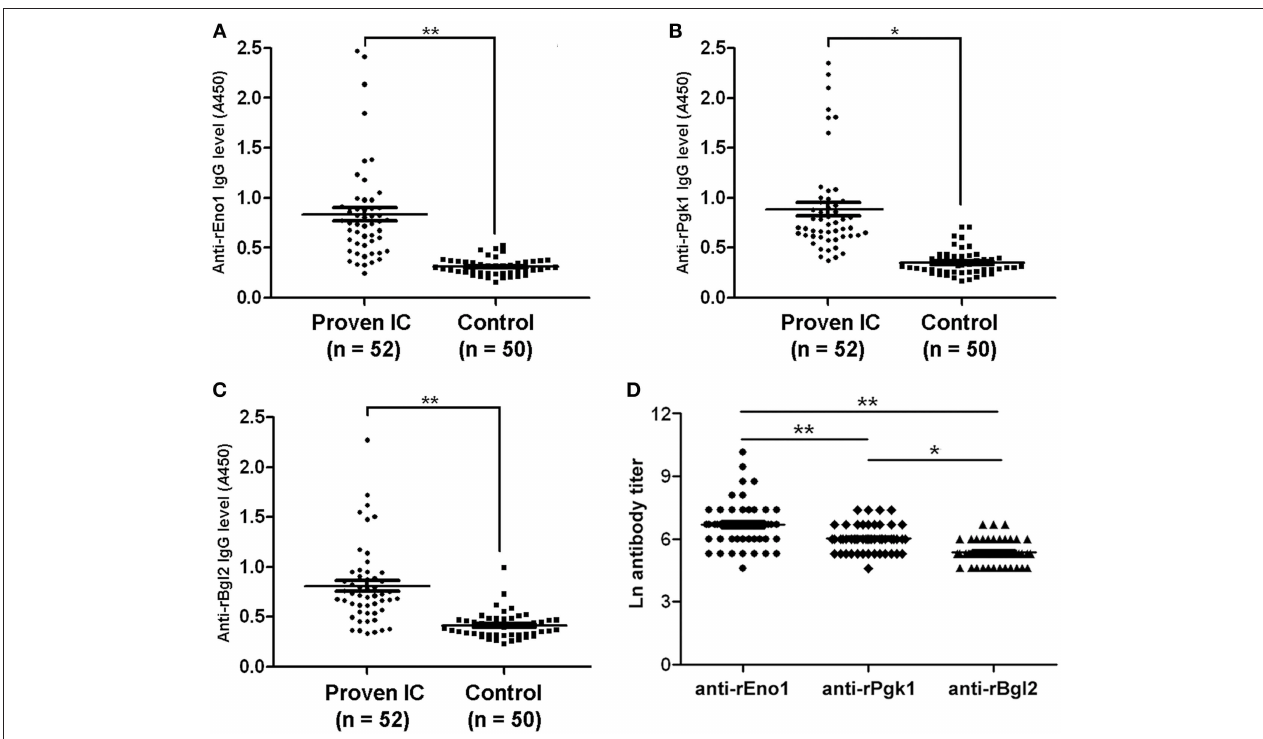
FIGURE 4 | Antibody levels and titers in study patients. The levels of anti-rEno1 (A) , anti-rPgk1 (B), and anti-rBgl2 (C) in human sera were determined by ELISA and human sera were pre-diluted before detection (1:400 for rEno1, 1:200 for rPgk1, and 1:100 for rBgl2). The levels of anti-rEno1, anti-rPgk1 and anti-rBgl2 in proven IC patients were higher than control group. (D) Ln antibody titers in proven IC patients. Anti-rEno1 antibody possesses the highest titer, followed by rPgk1 and rBgl2. Each symbol represents antibody level (or titer in D ) of individual human serum. The horizontal lines indicate the mean ± SEM for each group. Means were compared by Students t -test: ** P < 0 . 001 , * P = 0 .001.